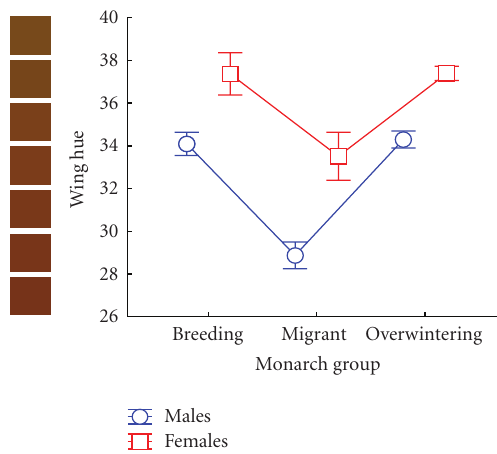
Figure 3: Average wing hue score (in degrees) across all groups for male ( n = 107) and female ( n = 67) monarchs in this study. Error bars represent 95%